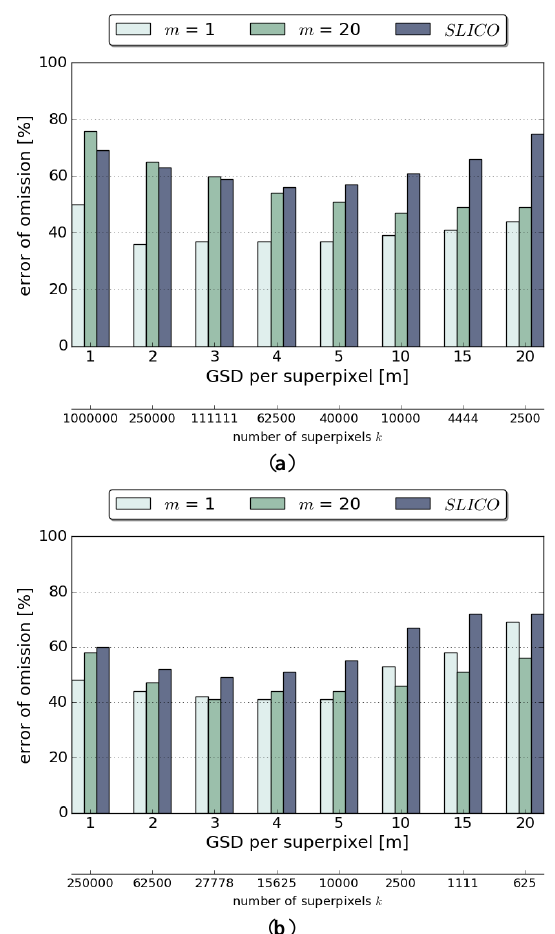
Figure 4. Errors of omission obtained for ( a ) Amtsvenn and ( b ) Toulouse. The number of superpixels k varies according to the extent covered per study area (Table